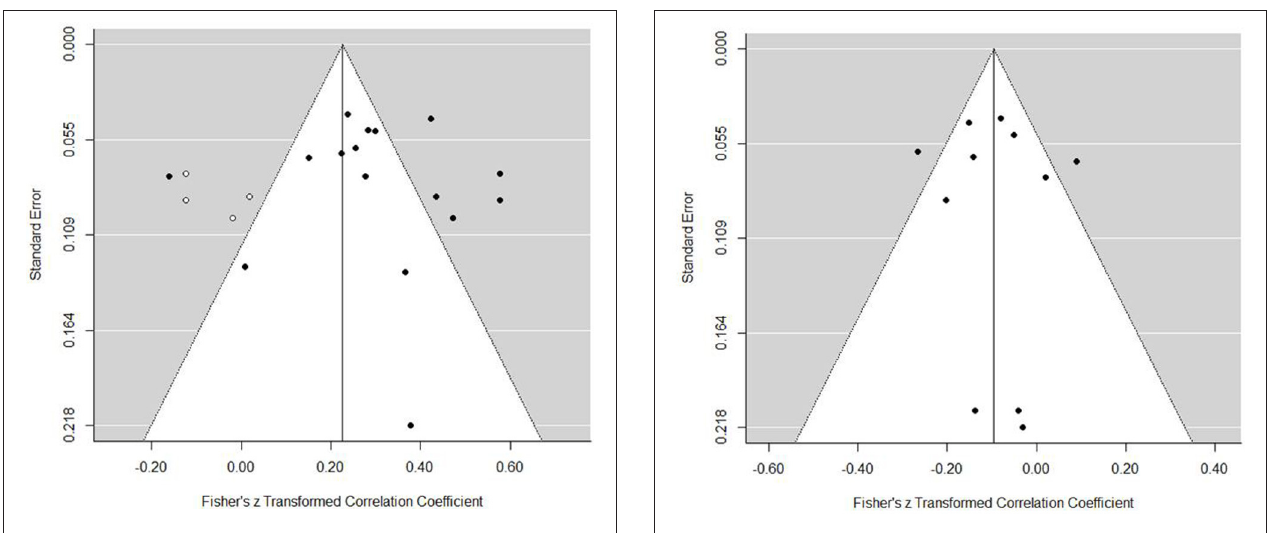
FIGURE 5 | Internal regulation coping forest plot. (Gaudreau and Blondin, 2004b; Hatzigeorgiadis, 2006; Gaudreau and Antl, 2008; Gaudreau et al., 2010; Levy et al., 2011; Nicholls et al., 2012a,b; Evans et al., 2014; Laborde et al., 2014a,b).